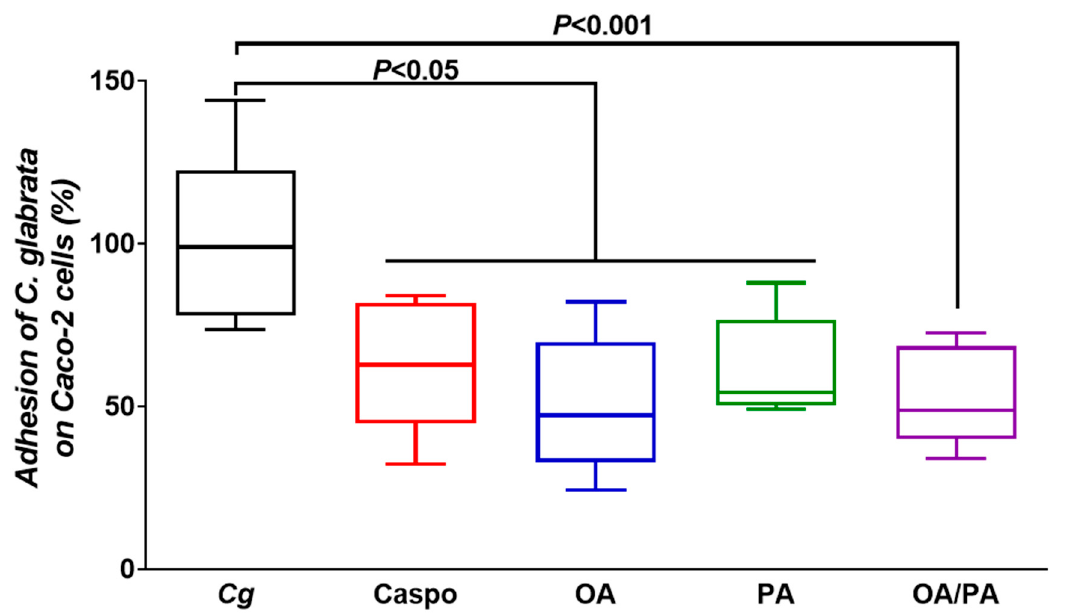
Figure 5. Effect of fatty acids on the adhesion of C. glabrata to Caco-2 cells. Cg : control (Caco-2 cells challenged with C. glabrata ); Caspo: standard control (Caco-2 cells challenged with C. glabrata and treated with caspofungin); OA, PA, OA/PA: Caco-2 cells challenged with C. glabrata and treated with OA, PA, or FAs (OA/PA), respectively. The results were obtained from two independent ex-